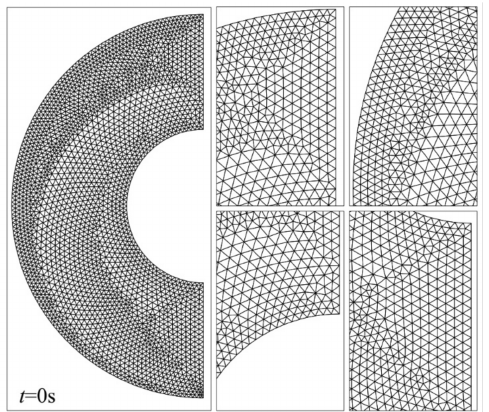
Figure 2. The impact of the mesh size on the melted volume fraction (MVF) of the phase change material ( a ) and the melting interface at a simulate time, t = 500 s ( b ) with a foam porosity ε of 0.80 (i.e., metal in the foam occupies 20% of the available volume), an eccentricity e of 0.22 r s , and no nanoparticles ( σ = 0.00).